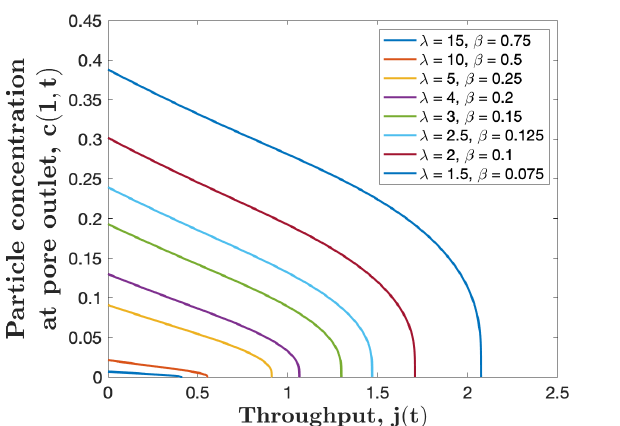
Figure 5. Particle concentration at the membrane downstream c ( 1, t ) , versus throughput j ( t ) for several values of λ with the initial pore profile a ( x ,0 ) = 0.9, Pe = 2, and ρ b = 2. We set λ ∝ β (corresponding to varying Λ